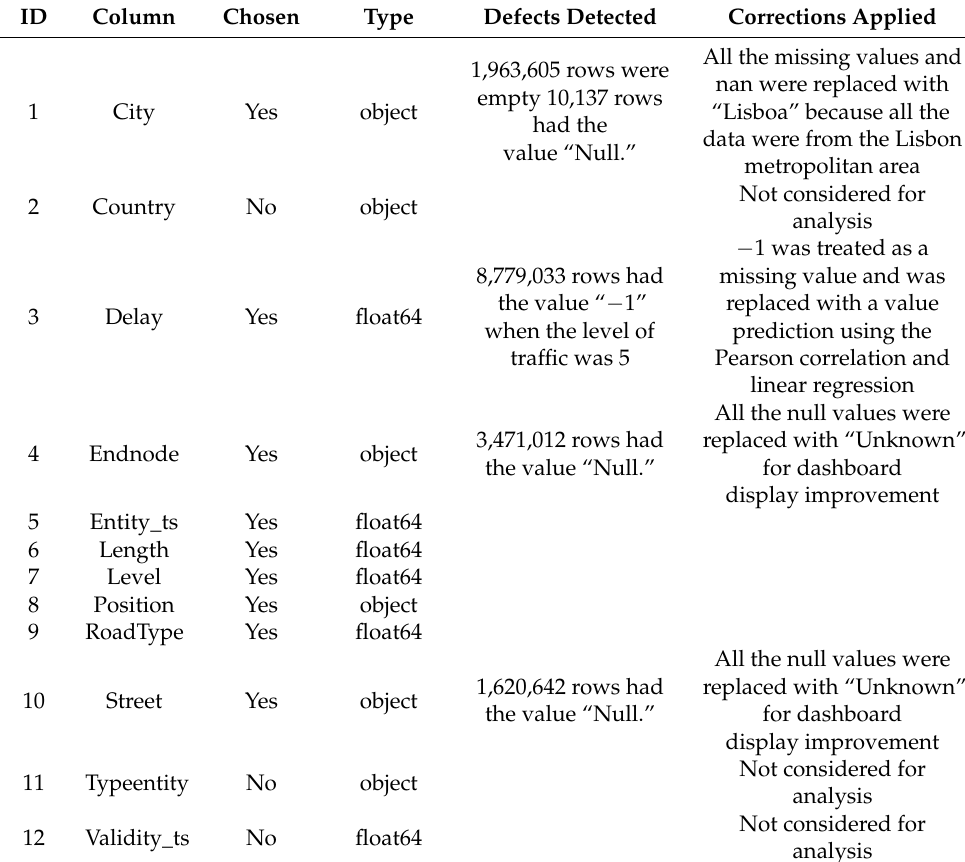
Table 7. Waze dataset—details and data